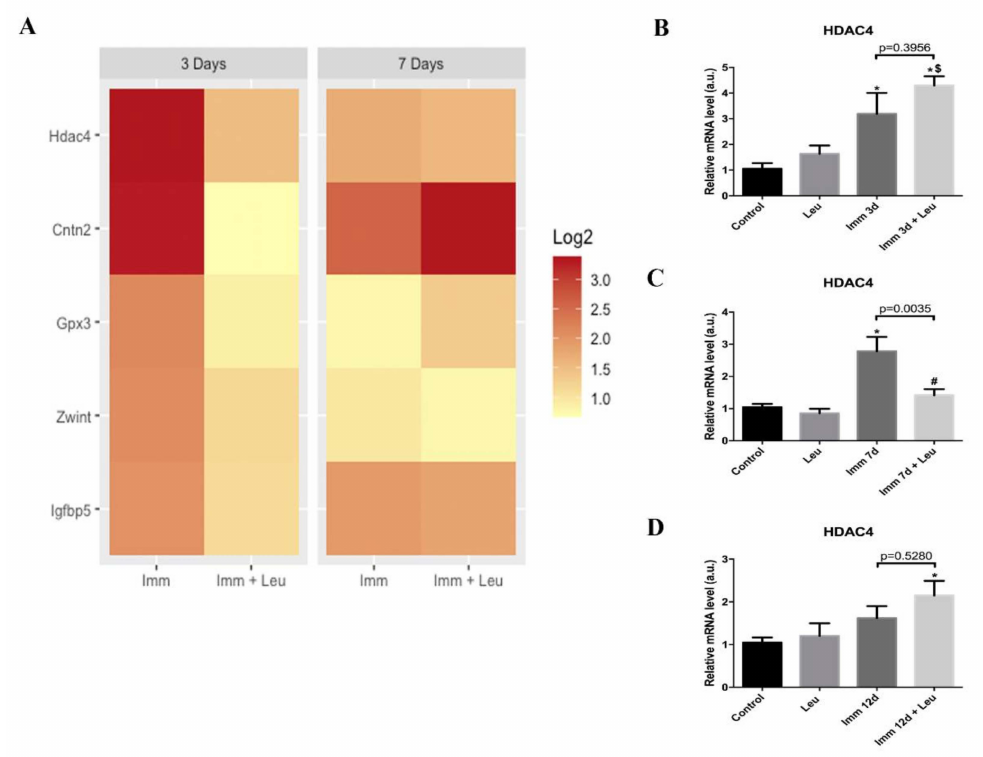
Figure 2. Genes responsive to hindlimb immobilization downregulated by leucine supplementation and HDAC4 validation at 3, 7 and 12 days. ( A ) Heat maps showing top di ff erentially expressed genes strongly upregulated at 3 days of hindlimb immobilization that were softened by leucine supplementation; the 7-day timepoint is shown as time reference ( n = 2 per group). ( B ) HDAC4 mRNA levels were determined by real-time PCR at 3 days ( n = 6), ( C ) 7 days ( n = 8) ( D ) and 12 days ( n = 4) after immobilization (two independent experiments were performed for 3 and 7 days, and one independent experiment was performed for 12 days). Cyclophilin A expression was used as housekeeping gene. Data are expressed as mean ± SEM. Statistical analysis included one-way ANOVA followed by Tukey’s posthoc test. * p < 0.05 vs. control group; # p < 0.05 vs. immobilized 7 d group; $ p < 0.05 vs. leucine